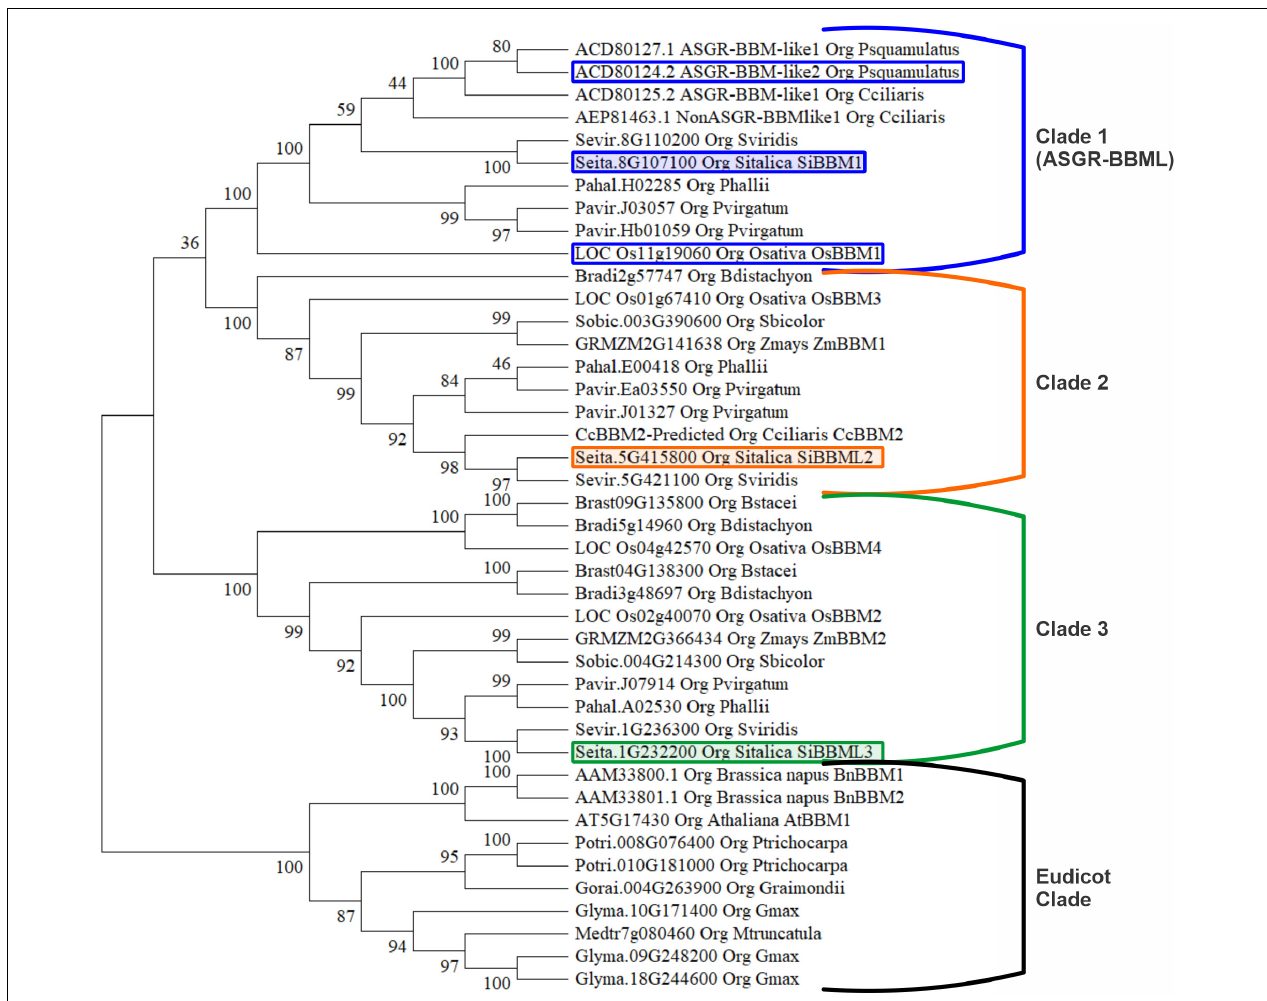
FIGURE 1 | Phylogenetic analysis of 42 BABY BOOM (BBM)/ BABY BOOM-like (BBML) proteins. The phylogenetic tree displays four distinct clades, including a eudicot clade and three monocot clades. The encircled and colored proteins are the Setaria italica BBM used in this study. The encircled proteins in clade 1 denotes BBM/BBML proteins which already had been shown to induce